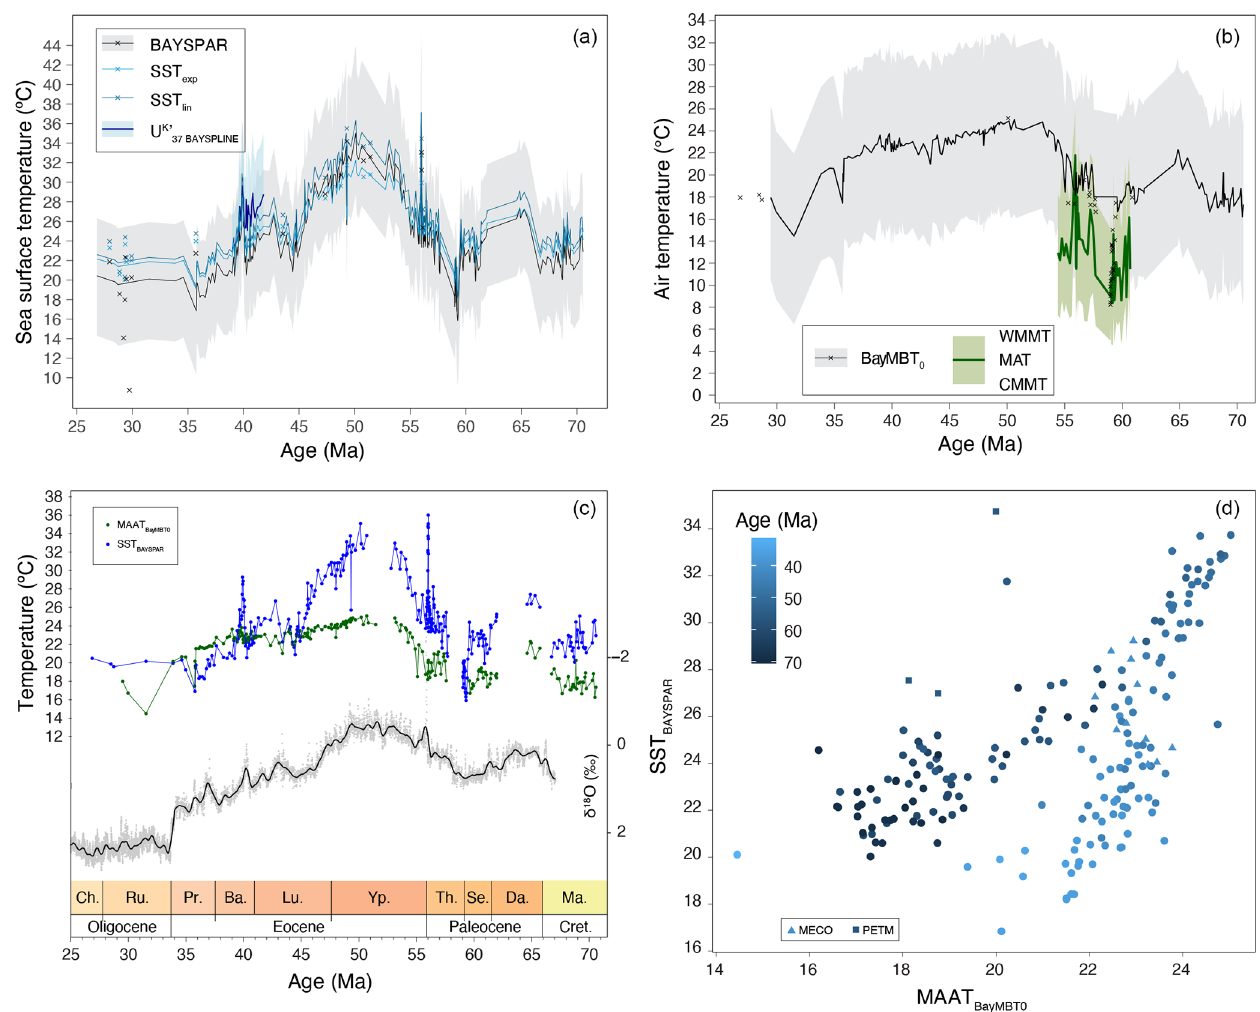
Figure 9. Paleothermometers. (a) TEX 86 -based SST reconstructions, using a Bayesian (BAYSPAR; black, with 90% confidence interval in gray envelope; Tierney and Tingley, 2015), exponential (SST exp ; light blue; Kim et al., 2010) and linear (SST lin ; dark blue; O’Brien et al., (cid:48) -based SSTs (thick blue line; from Bijl et al., 2010, recalculated using BAYSPLINE of Tierney and 2017) calibrations. Also plotted are U K 37 Tingley, 2018). Discarded samples are indicated by the crosses. (b) BrGDGT-based MAAT reconstructions using the Bayesian calibration (BayMBT 0 ; black, with 90% uncertainty interval in a gray envelope; Dearing Crampton-Flood et al., 2020). Discarded samples are indicated in crosses. Also plotted are pollen-based NLR-approach mean annual (MAT) reconstructions (thick dark green, with light green envelope representing coldest and warmest month mean temperatures; from Contreras et al., 2014). (c) SST and MAAT reconstructions using the Bayesian calibrations calibrations, with the CENOGRID benthic foraminifer oxygen isotope splice of Westerhold et al. (2020) (10-point locally weighted scatterplot smooth (LOESS) in gray; 500pnt LOESS in black). (d) Cross correlation between SST and MAAT using the calibrations shown in panel (c)